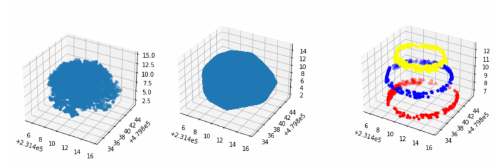
Figure 4. Points, random dist. points, slices